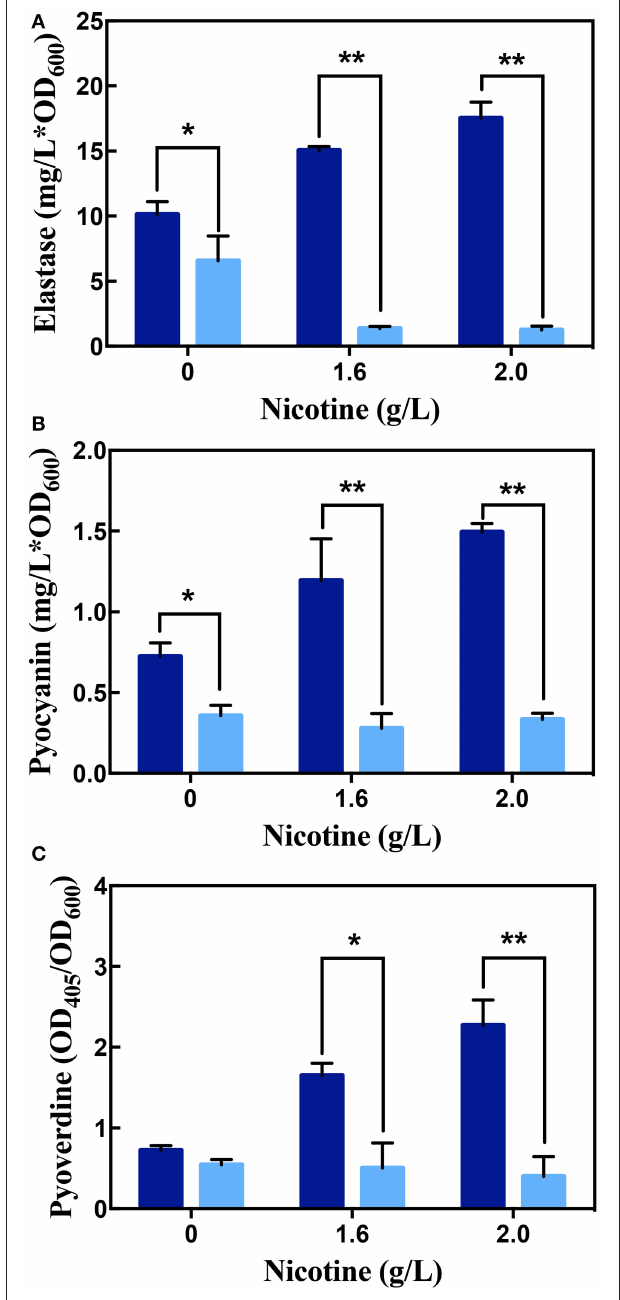
FIGURE 7 | The production of elastase (A) , pyocyanin (B) , and pyoverdine (C) in WT on exposure to different concentrations of nicotine, with (light blue bars) or without (dark blue bars) acylase I. ** and * indicate significant difference at p < 0.01 and p < 0.05, respectively.